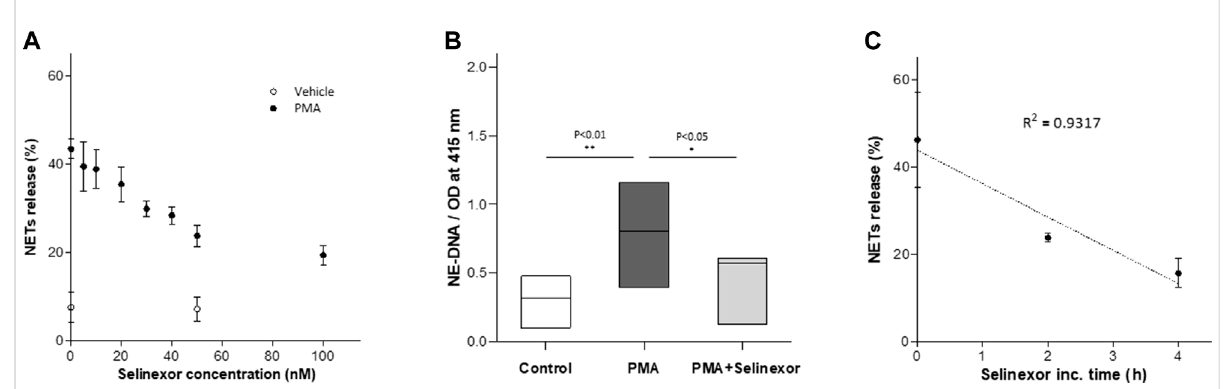
Selinexor inhibits NETs formation in a dose-dependent manner. Neutrophils were incubated with selinexor, at different concentrations, or a vehicle and then activated with PMA. NETs formation was assessed by confocal microscopy (A) Incubation with Selinexor at concentrations of 0 – 100 nM demonstrate that PMA-induced NETs formation 43.4% ± 2.2 ( N = 8) was inhibited and plateaued at a concentration of 50 nM Selinexor ( C , N = 8). Neutrophils incubated without PMA using 0 and 50 nM selinexor was used as control ( ○ , N = 8). (B) NE-DNA complex ELISA assay demonstrating reduced NETs formation ( N = 5, p < 0.01) following incubation with 50 nM Selinexor andPMA activation compared to PMA activation alone (OD 0.47 ± 0.09 vs. 0.83 ± 0.13 accordingly). Neutrophils incubated without PMA and selinexor were used as negative control and had a value of 0.30 ± 0.08. . (C) Positive correlation between selinexor incubation time and inhibition of NETs formation was observed ( R 2 =